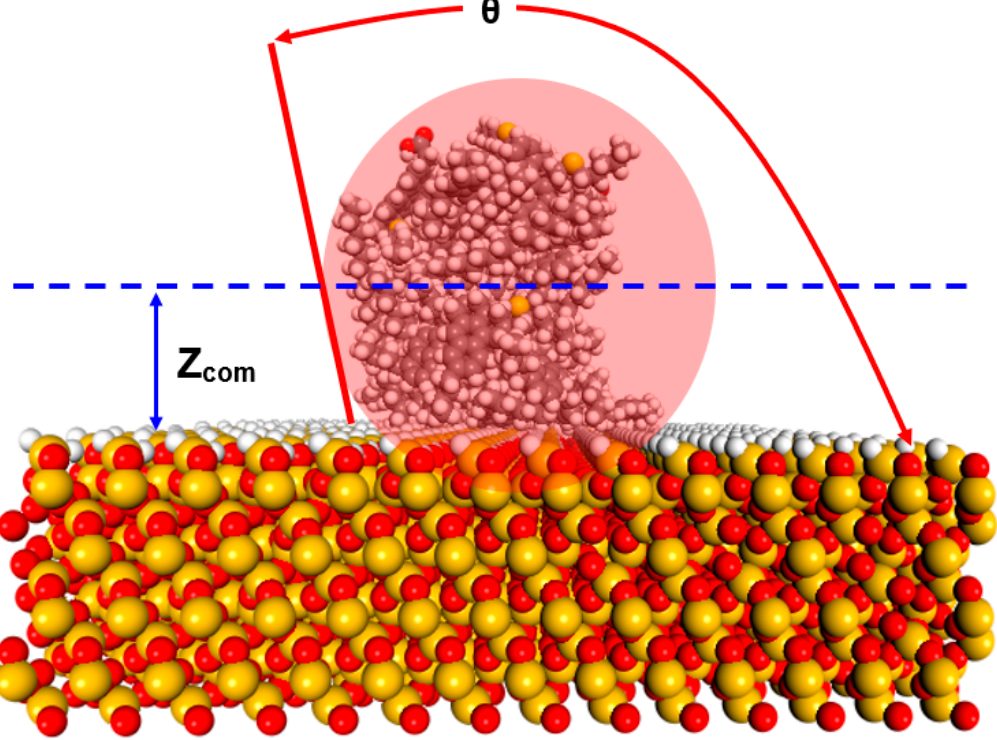
Figure 5. Graphical illustration of the contact angle measurement between heavy oil droplets and a quartz